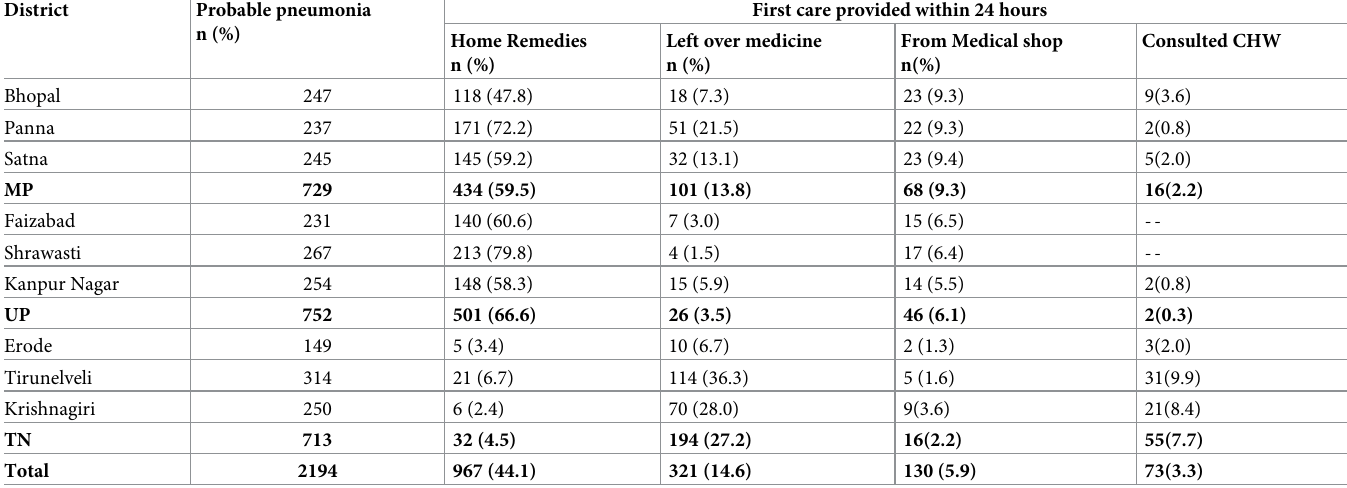
Table 4. Nature of first care